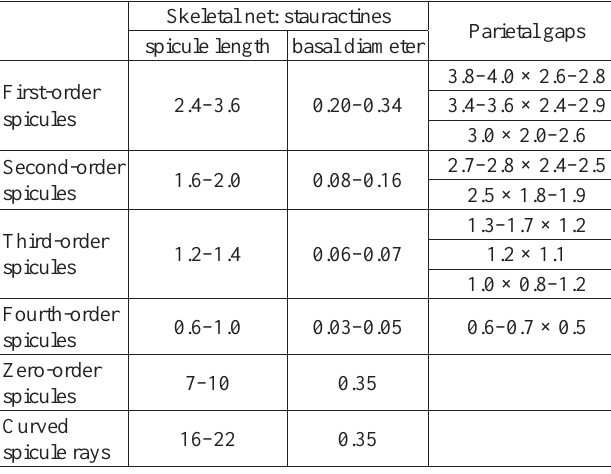
Table 1. Measurements (in mm) of spicules of Ratcliffespongia ari- vechensis sp. nov. from middle Cambrian El Mogallón Formation, Sonora,